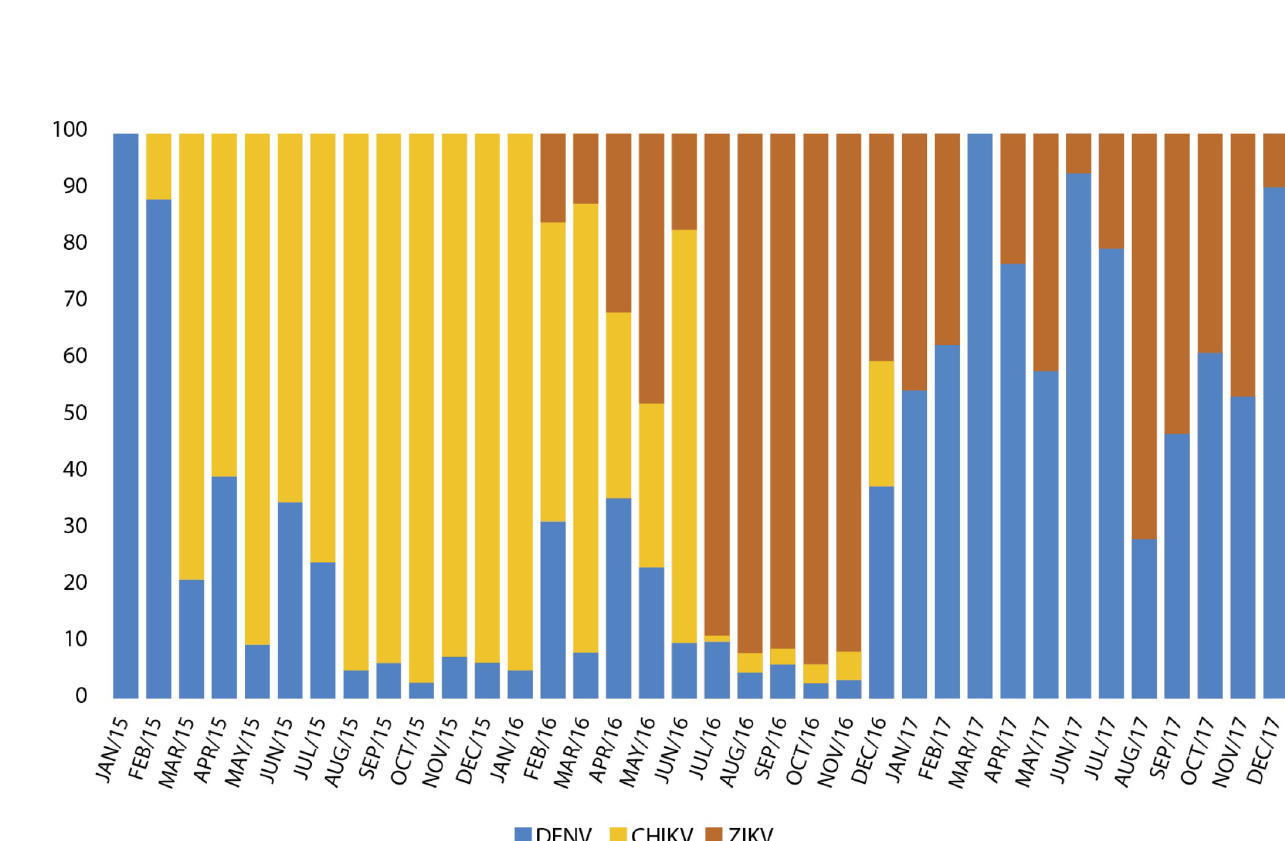
Fig 4. Contributions of DENV, CHIKV, and ZIKV to the etiology of arbovirosis 2015–2017. The graph was built from the estimated annual incidents generated with the data obtained in this work for each of the viruses, distributed monthly from 2015 to 2017.